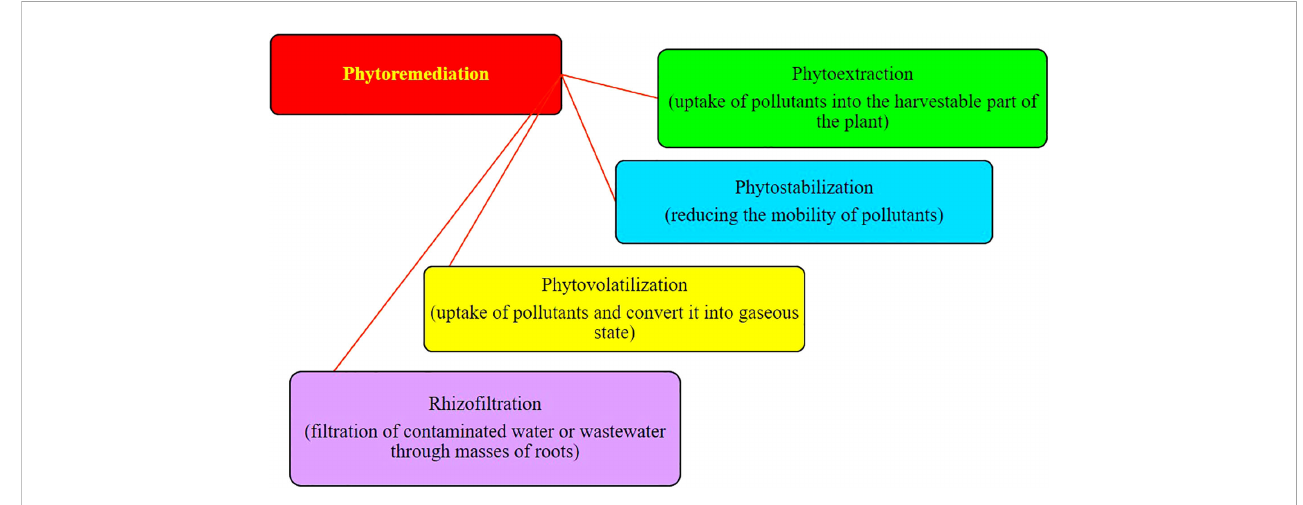
FIGURE 1 Various mechanisms involved in the phytoremediation of heavy metals.